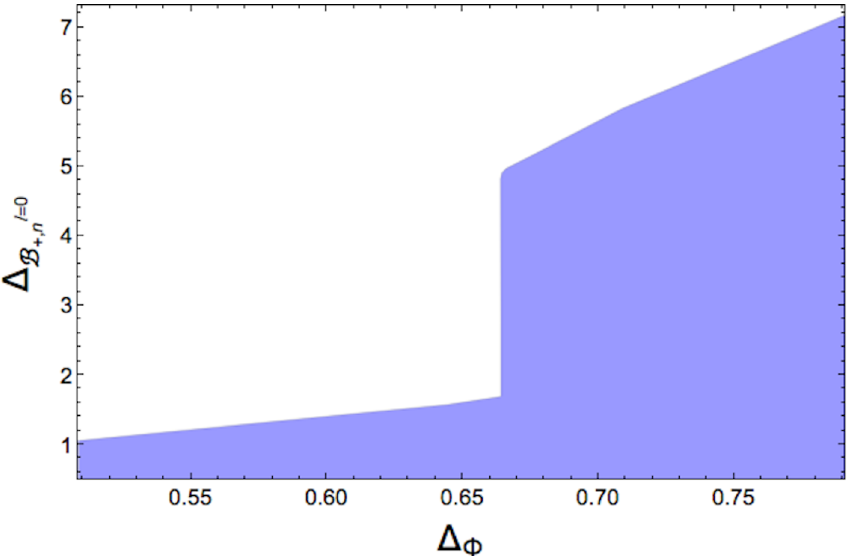
as a function of the flavor symmetry Φ